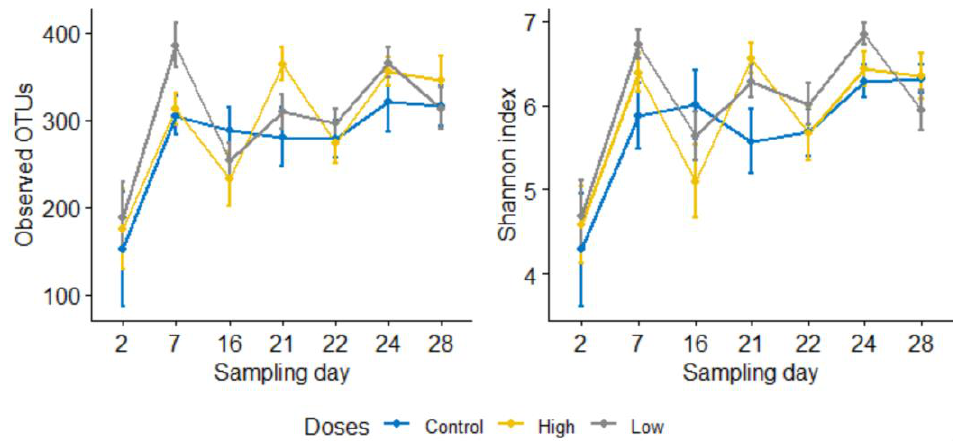
Figure 1. Line graphs comparing microbial richness and evenness measured by observed OTUs ( left ) and Shannon index ( right ) in the control group and combined low and high dose enrofloxacin treatment groups by sampling days. The differences were insignificant among the three groups on each sampling day for both metrics ( p > 0.05). All calves were inoculated with laboratory strains of C. jejuni on day 5; the BRD groups were challenged with M. hemolytica on day 13; and the treatment groups were administered enrofloxacin on day